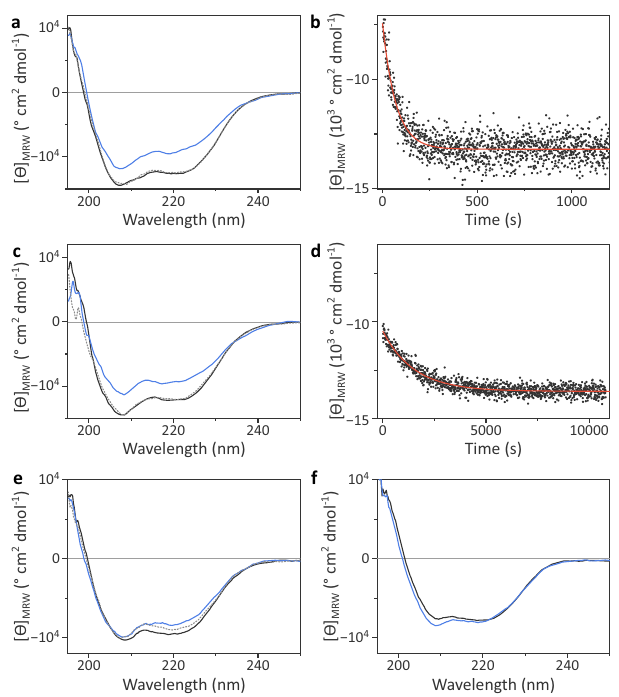
Fig. 4 Light response of As LOV2 variants. a Far-UV circular dichroism (CD) spectra of As LOV2 in its dark-adapted (black) and light-adapted states (blue), and after dark recovery (gray dotted). b Recovery reaction of As LOV2 following blue-light exposure, as monitored by the CD signal at (220 ± 5) nm. Data were fi tted to a single-exponential decay (red line), yielding a recovery rate constant k − 1 of (1.43 ± 0.05) × 10 − 2 s − 1 . c As a but for As LOV2 Q513L. d As panel b but for As LOV2 Q513L, with k − 1 amounting to (6.61 ± 0.15) × 10 − 4 s − 1 . e As a but for As LOV2 C450A:Q513D. f As a but for As LOV2 C450A:Q513D Δ A ’ α Δ J α . Experiments were repeated at least twice with similar